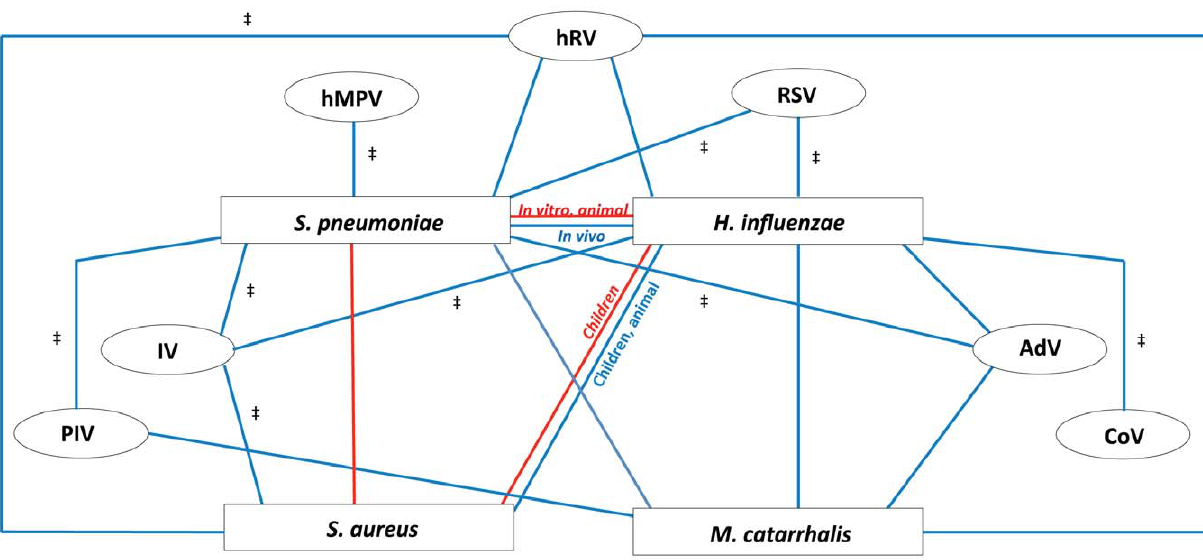
Figure 3. Proposed model of bacterial and viral interactions. This model represents the cumulative dynamics of bacterial and viral interactions occurring within the nasopharyngeal niche during asymptomatic episodes as observed in all cumulative literature references. All available information on the four main potential pathogenic bacteria ( Streptococcus pneumoniae , Haemophilus influenzae , Staphylococcus aureus , and Moraxella catarrhalis ) and seven common respiratory viruses (rhinoviruses (hRV), respiratory syncytial virus (RSV), adenoviruses (AdV), coronavirus (CoV), influenza viruses (IV), para-influenza viruses (PIV), and human metapneumovirus (hMPV)) are depicted. Red lines represent a negative association of co-colonization (competition), blue lines represent a positive association of co-colonization (synergism). For all depicted associations, evidence is available from human (surveillance) studies, except for those indicated with { , where evidence is only available from in vitro and/or animal studies.